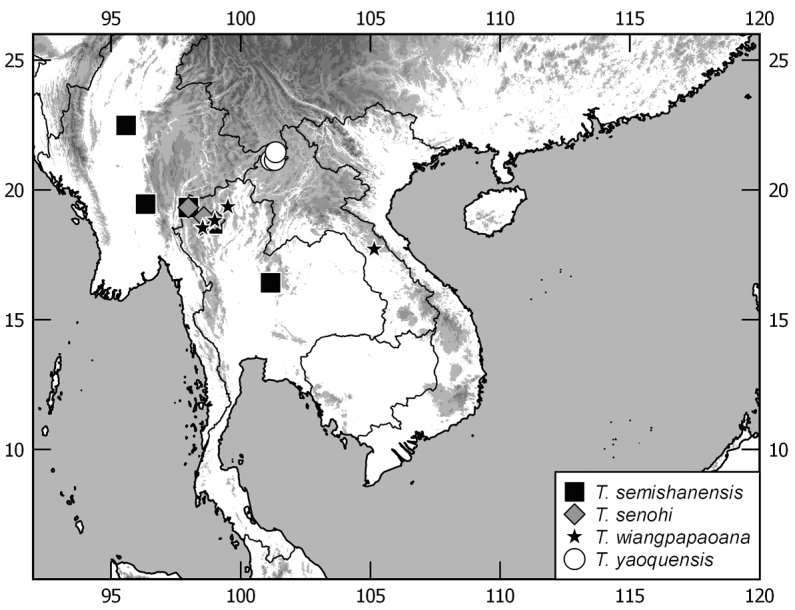
Distribution map of Tetrasericasemishanensis sp. n., T.senohi Kobayashi, 2018, T.wiangpapaoana Kobayashi, 2017, T.yaoquensis Liu et al., 2014.